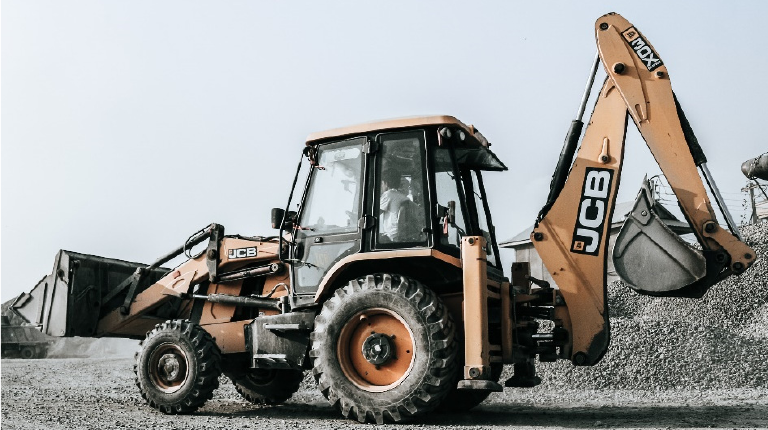
Figure 2. Tractor–loader–backhoes are tractors with a front-mounted loader and a back-mounted backhoe as attachments.